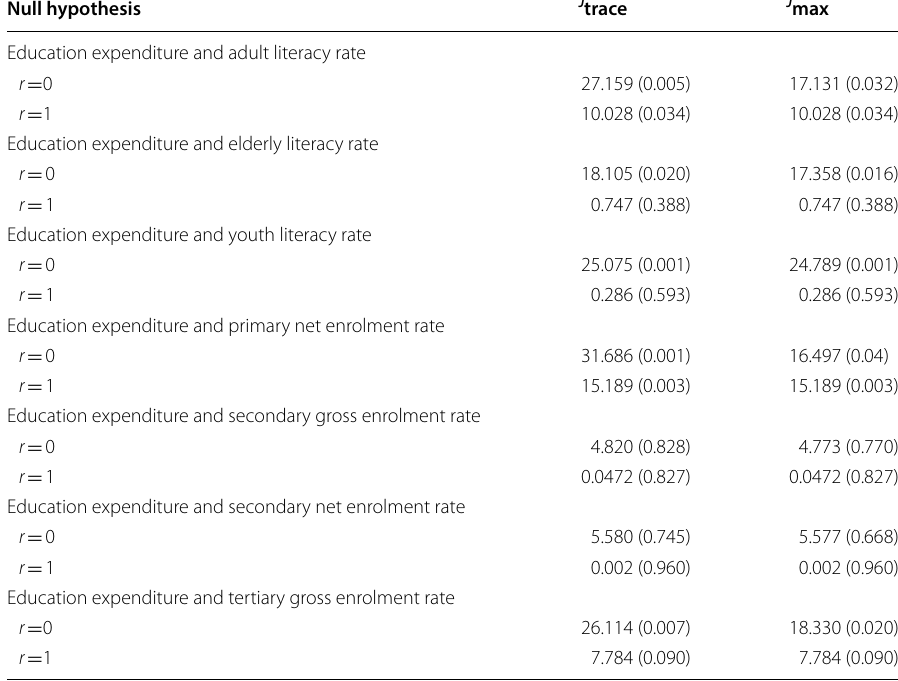
Table 4 Results of co-integration test between education expenditure and education output